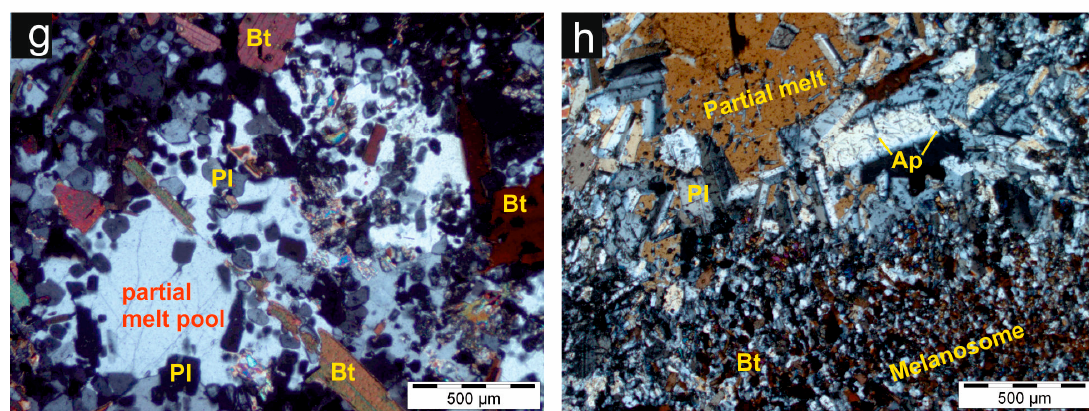
Figure 4. Texture of the charnockite in the WM-002 drill core (Spruce Road deposit). ( a ) Net-texture of Euhedral ortho- and clinopyroxene crystals in a sulfide matrix, composed of pyrrhotite (Po), Pentlandite (Pn), and chalcopyrite (Ccp) (XPL image). ( b ) Partial melt film between plagioclase porphyroblasts. The partial melt crystallized to quartz ± K-feldspar ± plagioclase (SEM image). ( c ) Sieve textured feldspar partially replaced by sulfide minerals (pyrrhotite, pentlandite, and chalcopyrite) (XPL image). ( d , e ) Partial melt pocket—note the euhedral clinopyroxene crystal and the quadrant plagioclase crystals. The partial melt crystallized to quartz (white) (XPL image). ( f ) Euhedral biotite II intergrown with euhedral apatite (PPL image). Texture of the metapelite in the B1-178 drill core (Serpentine deposit). ( g ) Partial melt pocket—note the euhedral biotite crystals and the quadrant plagioclase crystals. The partial melt crystallized to quartz (light blue) (XPL image). ( h ) Partial melt in the metapelite. The fine-grained melanosome is rich in biotite and plagioclase. The partial melt crystallized to coarse-grained plagioclase, biotite, and quartz. Note the abundant euhedral apatite crystals as inclusions in plagioclase (XPL